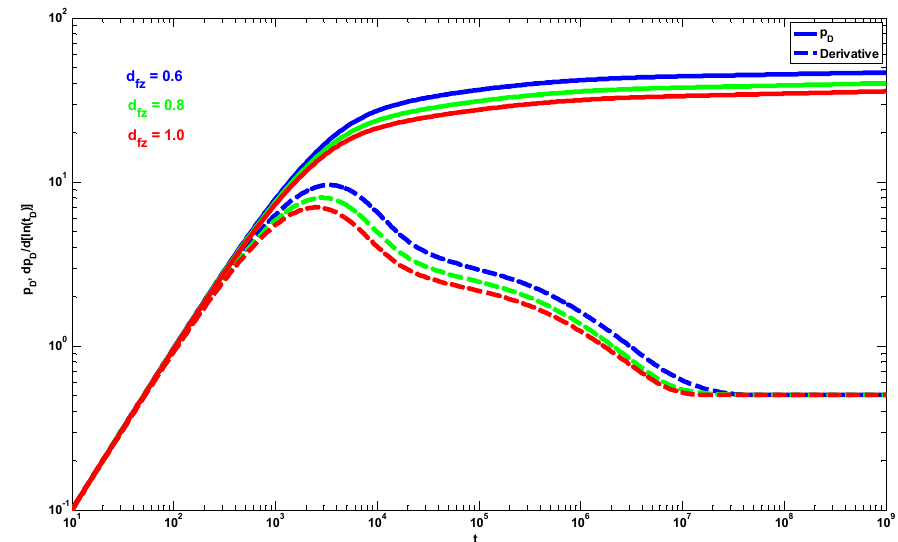
Figure 8. Fractal case: z wD = 0.4, h D = 10,000, h pD = 0.2, S = 0, C D = 100, ε = 1, d fr = 2.0, θ r = 0, θ z = 0.